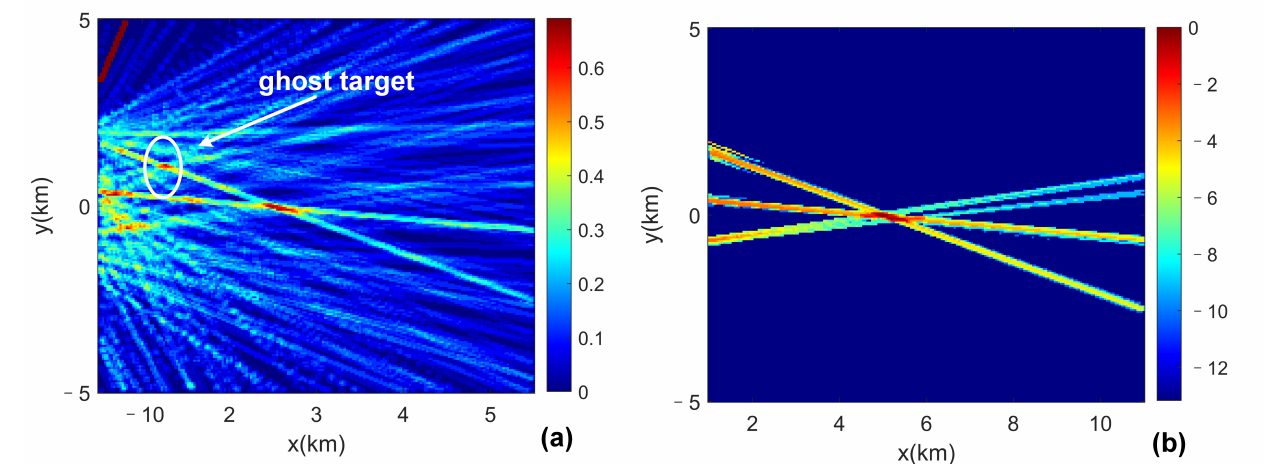
Figure 9. (Color online) ( a ) The inter-array intersection pattern of the Basic-FLFL method; ( b ) The inter-array intersection pattern of the proposed HT-FLFL method. The SNR is set to be − 10 dB in this